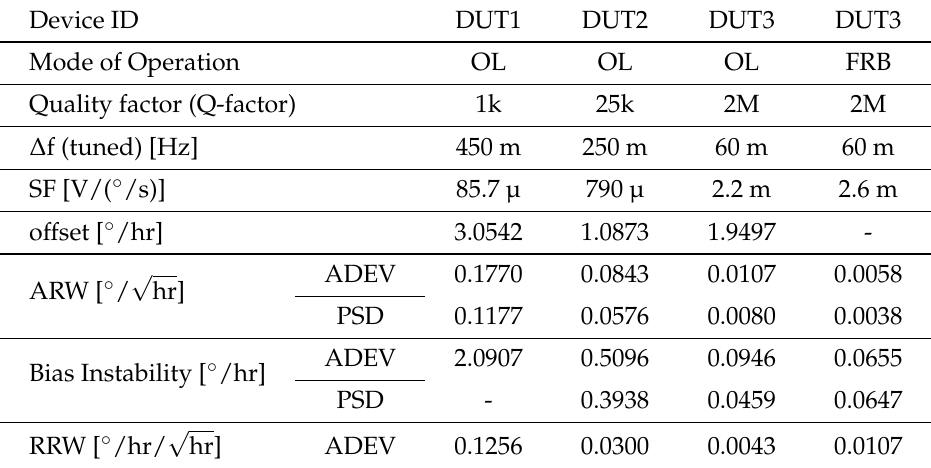
Figure 20. Noise characteristics of QMG with different Q-factor conditions with curve fit lines estimating ARW (slope –1/2), bias instability (slope 0) and RRW (slope + 1/2) for QMG in the open- loop operation for ( a ) Q = 1k, ( b ) Q = 25k, ( c ) Q = 2M, and ( d ) in the closed-loop (FRB) operation mode, Q = 2M. Table 3. Summary of device parameters and noise